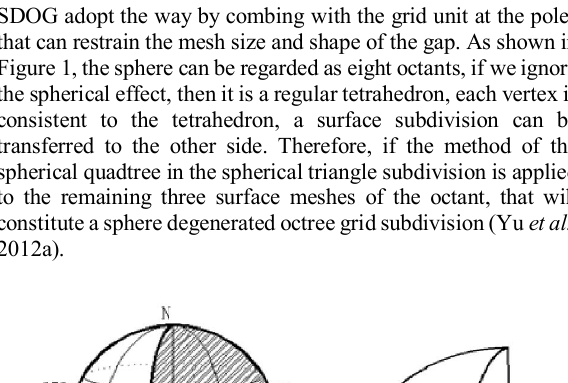
Figure 2. Octant subdivision process